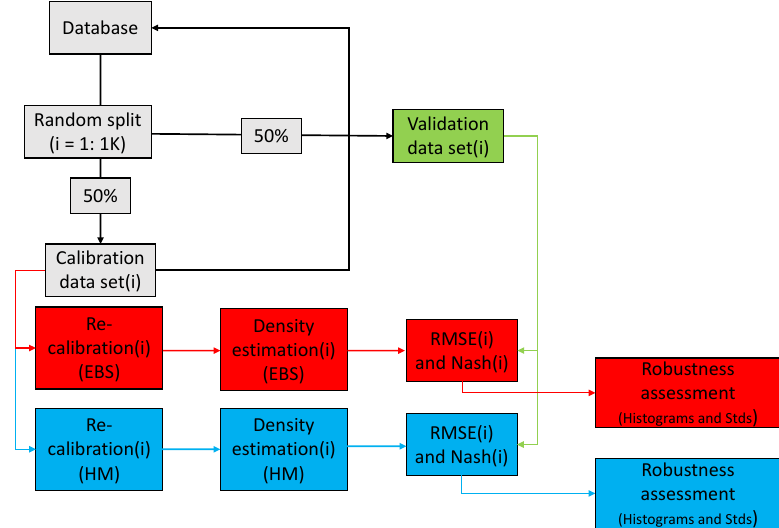
Figure 6. Stability test (k-fold cross-validation) flow chart.